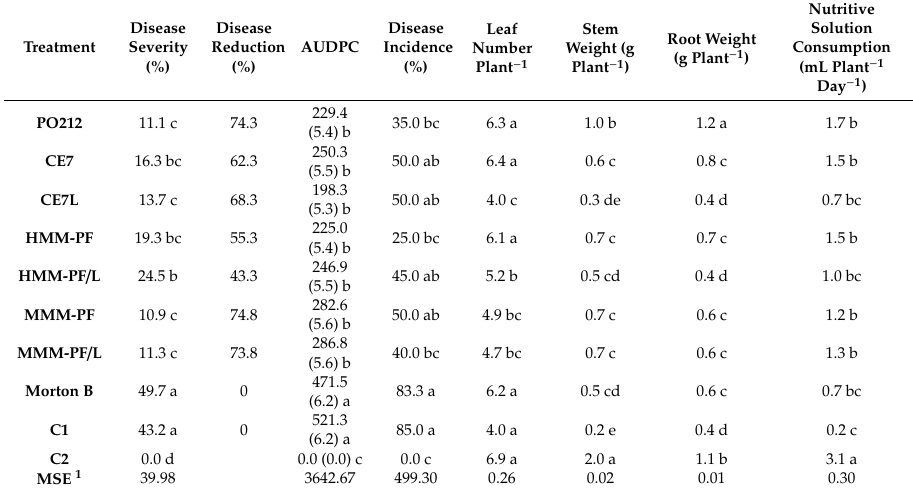
Table 7. E ff ect of freeze-drying of the high and middle molecular mass protein fractions (HMM-PF and MMM-PF) on the disease control caused by strain 1A of Fusarium oxysporum f.sp. lycopersici (FOL1A) and tomato plants growth.